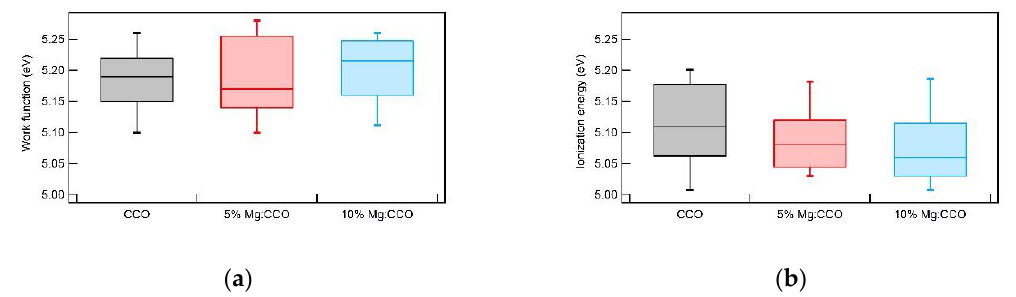
Figure 9. Box plots of ( a ) work function and ( b ) ionization energy for CCO (black color), 5% Mg:CCO (red color), and 10% Mg:CCO (blue color) films. The percentiles are set to 90% whisker top, 75% box top, 25% box bottom, and 10% whisker bottom for each data set. In (a), 20 batches of WF measurements are used in each data set. In (b), 13 batches of IE measurements are used in each data set.